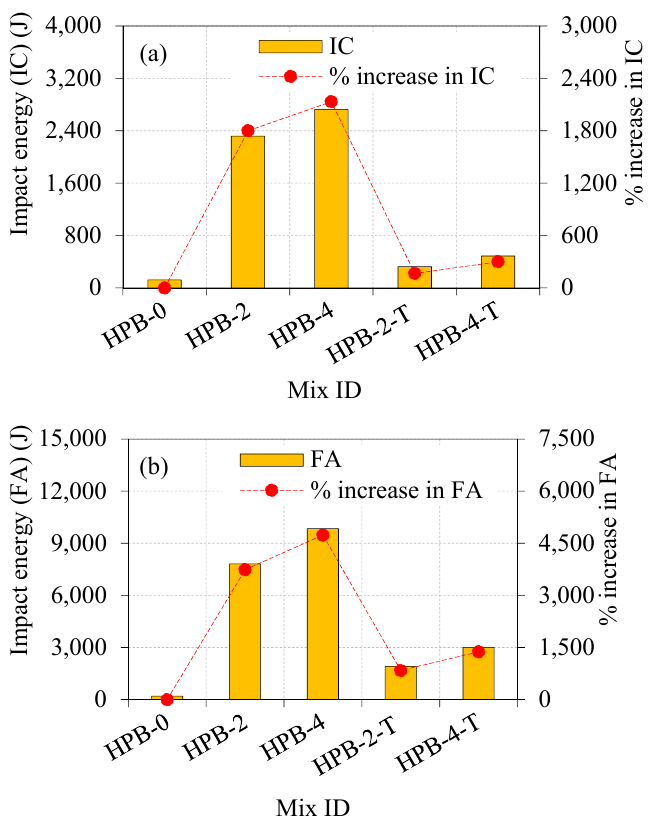
Figure 12. Impact energies at initial crack and failure ( a ) Impact energy at IC and ( b ) Impact energy at FA. Crystals 2020 , 10 , x FOR PEER REVIEW